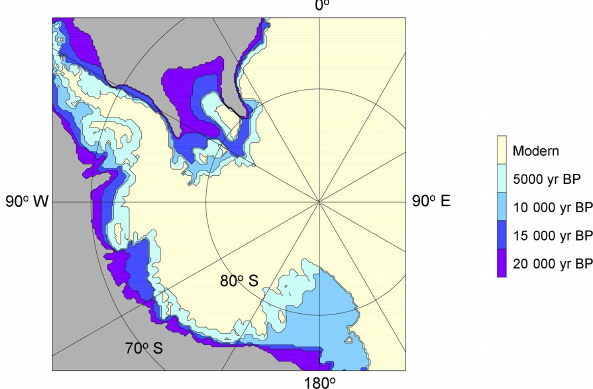
Figure 1. Geographical map of West Antarctica. Light yellow shows the modern extent of grounded ice (using Bedmap2 data; Fretwell et al., 2013). Blue and purple areas show expanded grounded-ice extents at 5, 10, 15 and 20ka (thousands of years before present) reconstructed by the RAISED Consortium (2014), plotted using their vertex information (S. Jamieson, personl com- munication, 2015), and choosing their Scenario A for the Weddell embayment (Hillenbrand et al., 2014). These maps are used in the large ensemble scoring (TOTE, TROUGH and GL2D data types, Sect.